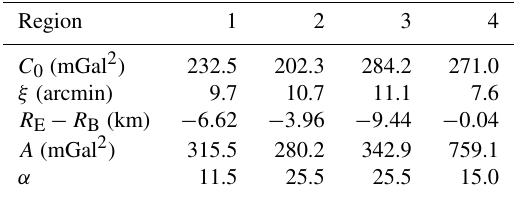
Table 7. Parameters of the empirical and analytical COVs after the data distribution refinement in each